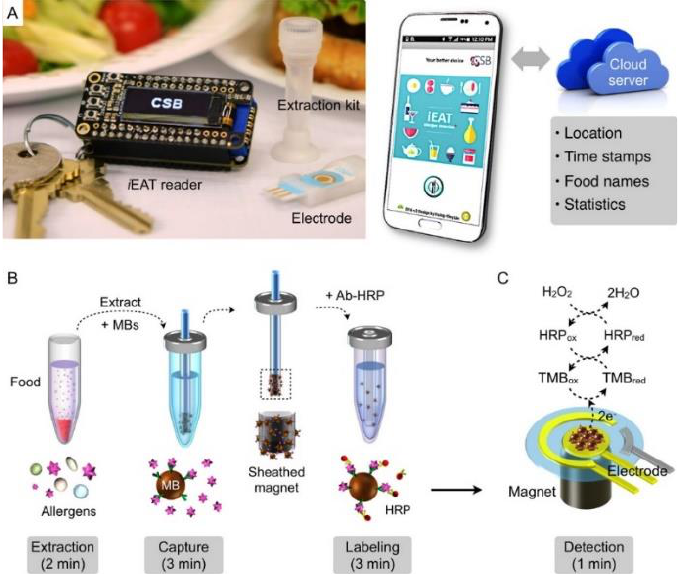
Figure 5. iEAT system for on-site allergen detection. ( A ) The system consists of a pocketsize detector, an electrode chip, and a disposable kit for allergen extraction. The detector is connected to a smartphone for system control and data upload to a cloud server. ( B ) Antigen extraction. Antigens are captured on MBs and then labeled with antibodies conjugated with HRP. ( C ) For signal detection, HRP-coated MBs are mixed with electron mediators (TMB, 3,3′,5,5′ -tetramethylbenzidine) and dropped on the electrode. HPR catalyzes the oxidation of TMB. Reprinted with permission from [108]. Copyright 2017 American Chemical Society.